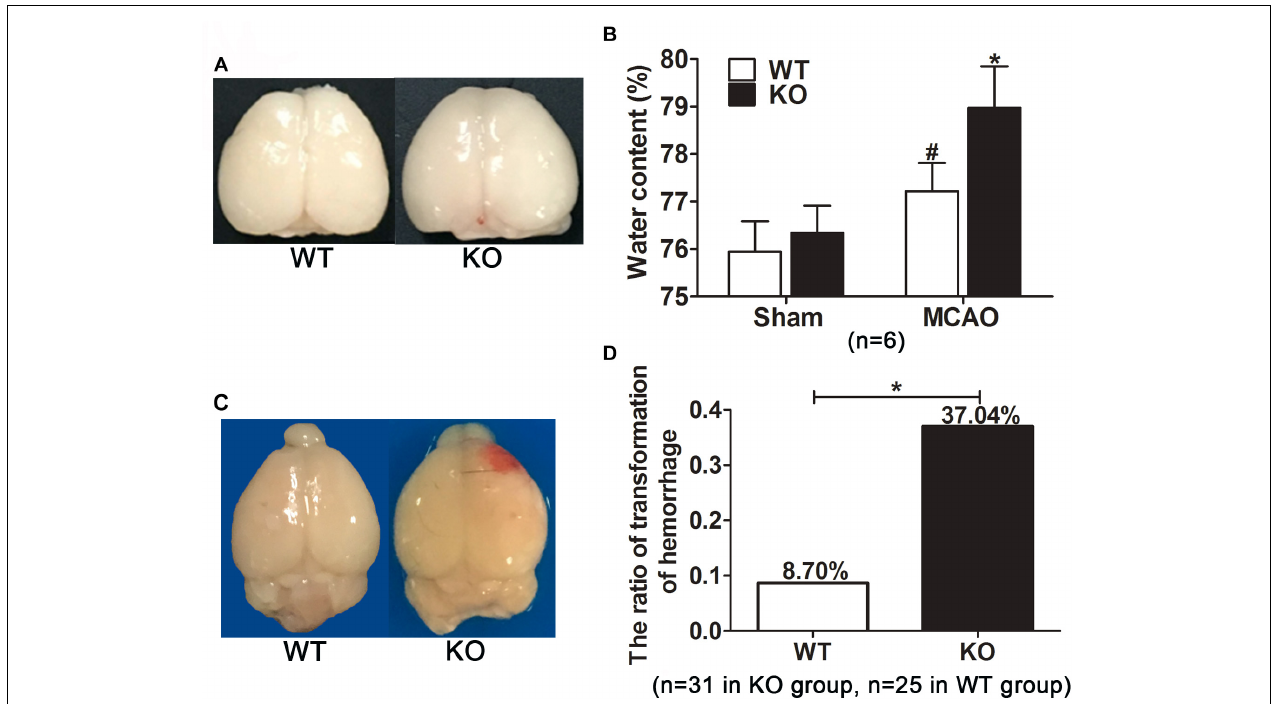
FIGURE 3 | Irak3 knockout increased brain water content and the incidence of cerebral hemorrhage transformation after reperfusion. (A) After 45 min tMCAO and 24h reperfusion, brains were isolated and photographs showing brain edema was captured. (B) Water content was measured by wet/dry method. Cerebral ischemia resulted in a marked increment in water content. IRAK-M deficiency accentuated brain swelling in MCAO mice compared with WT group. Data are expressed as mean ± SD, n = 6 per group. (C) Representative photographs showing the visible hemorrhagic foci appeared on the infarcted brain of the KO mice. (D) The incidence of cerebral hemorrhage transformation in each group was calculated. n = 31 in KO group and n = 25 in WT group. ∗ P < 0.05 vs. WT group, # P < 0.05 vs. sham